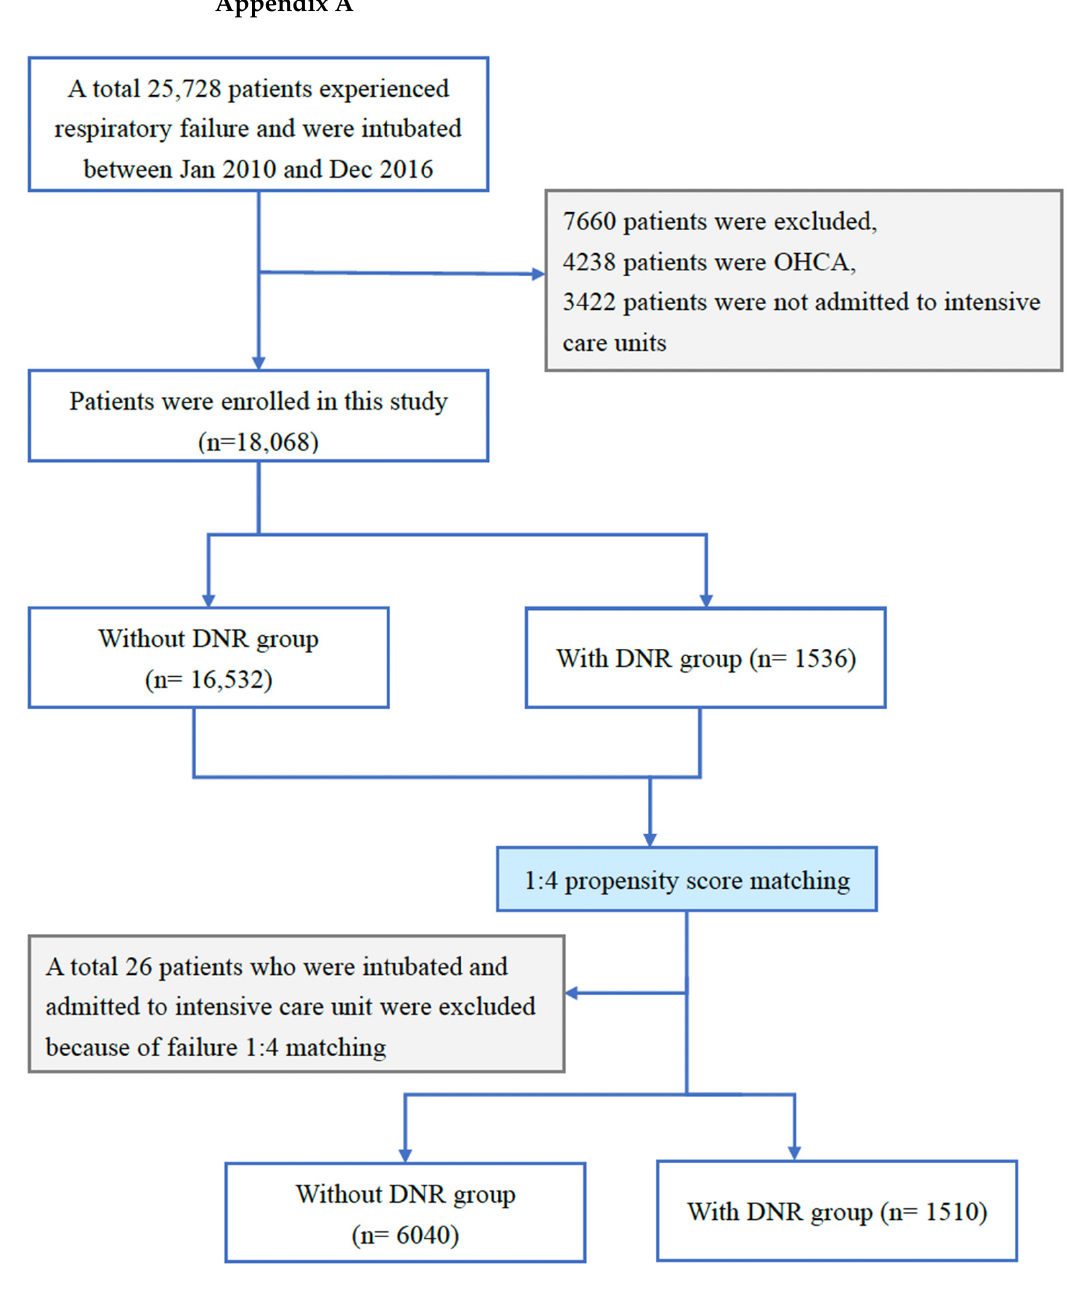
Figure A1. Flowchart of enrollment and status of patients. The 1:4 propensity score matched by age, sex, myocardial infarction, heart failure, cerebrovascular accident, chronic obstructive pulmonary disease, liver cirrhosis, chronic kidney disease, malignancy, and main diagnosis. Abbreviations: OHCA, out-of-hospital cardiac arrest; DNR, do-not-resuscitate.